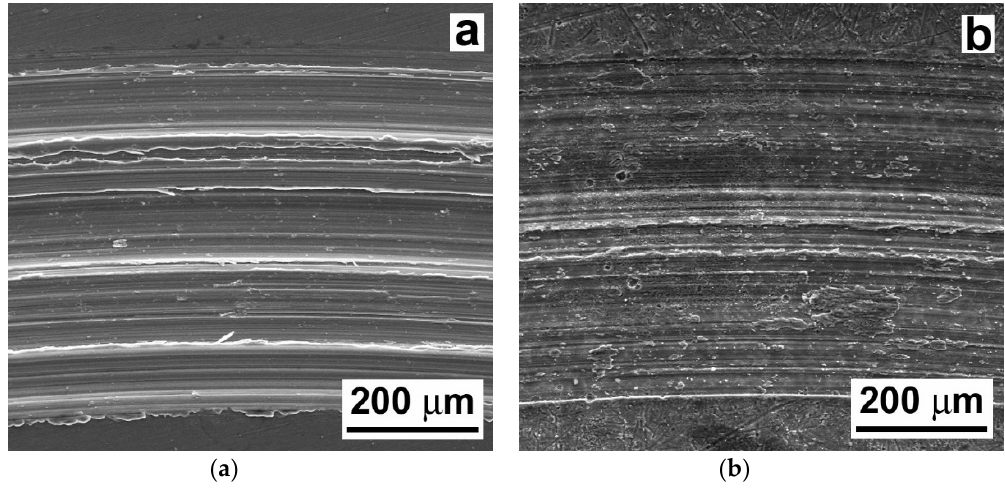
Figure 11. SEM images showing morphological characteristics of the wear tracks in AZ61–10